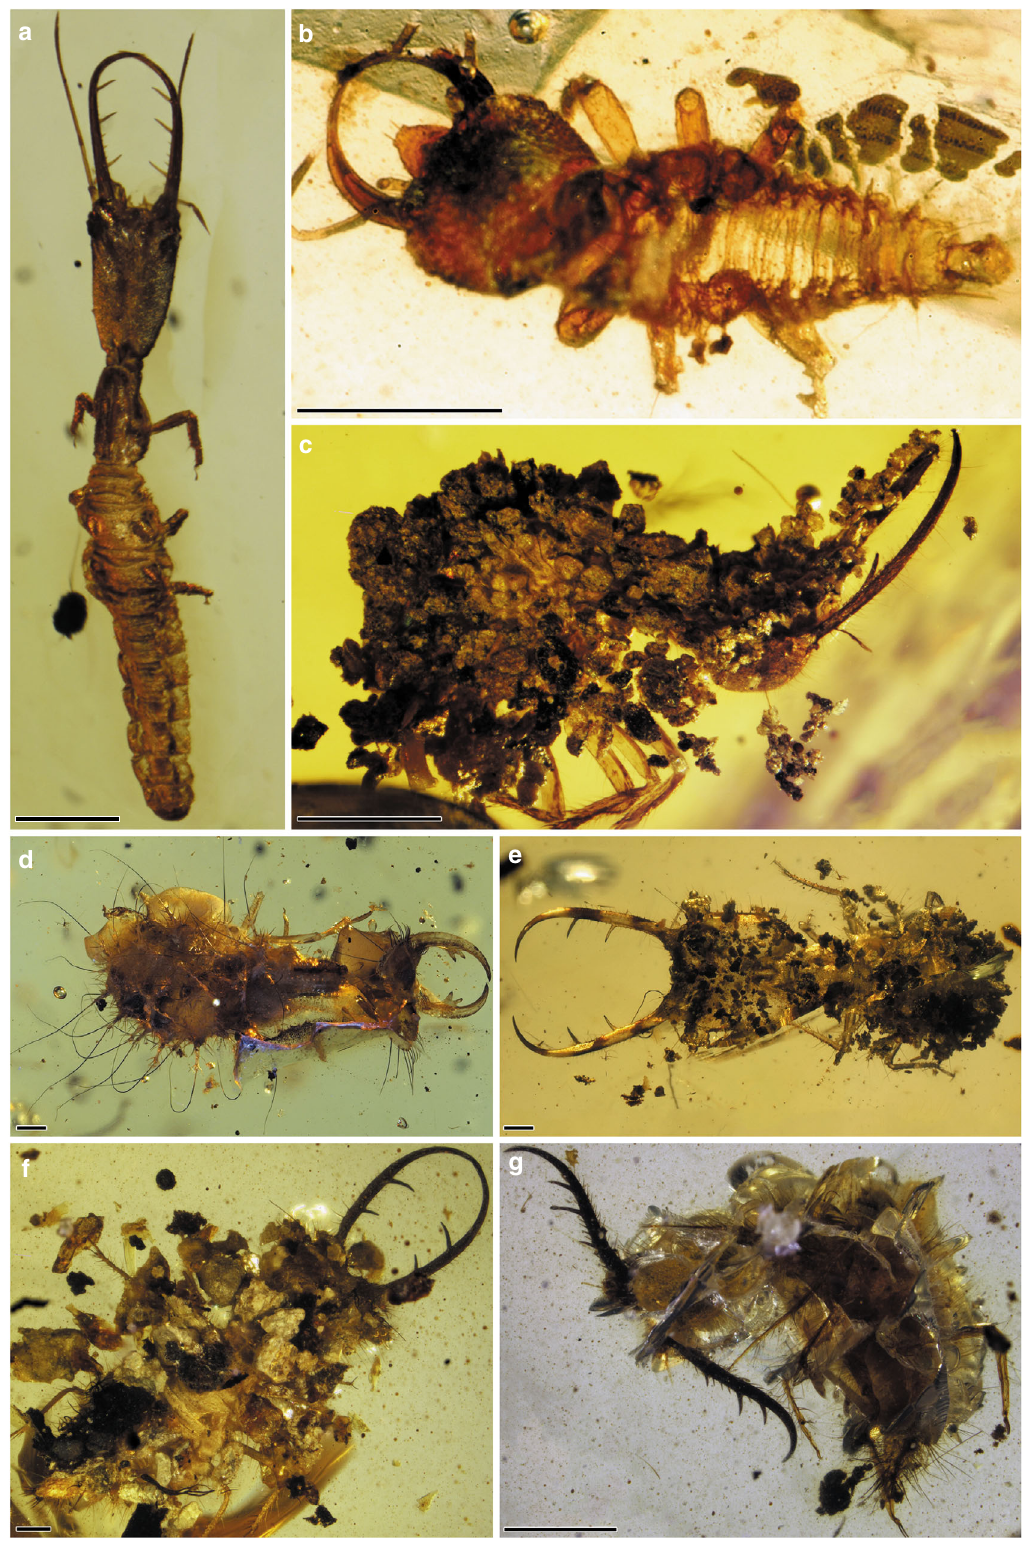
Fig. 3 Diversity of the larvae of Myrmeleontiformia in mid-Cretaceous Burmese amber. a Macleodiella electrina gen. et sp. nov., holotype. b Aphthartopsychops scutatus gen. et sp. nov., holotype. c Nymphavus progenitor gen. et sp. nov., paratype. d Electrocaptivus xui gen. et sp. nov., holotype. e Diodontognathus papillatus gen. et sp. nov., holotype. f Adelpholeon lithophorus gen. et sp. nov., holotype. g Pristinofossor rictus gen. et sp. nov., holotype. Scale bars: 0.5